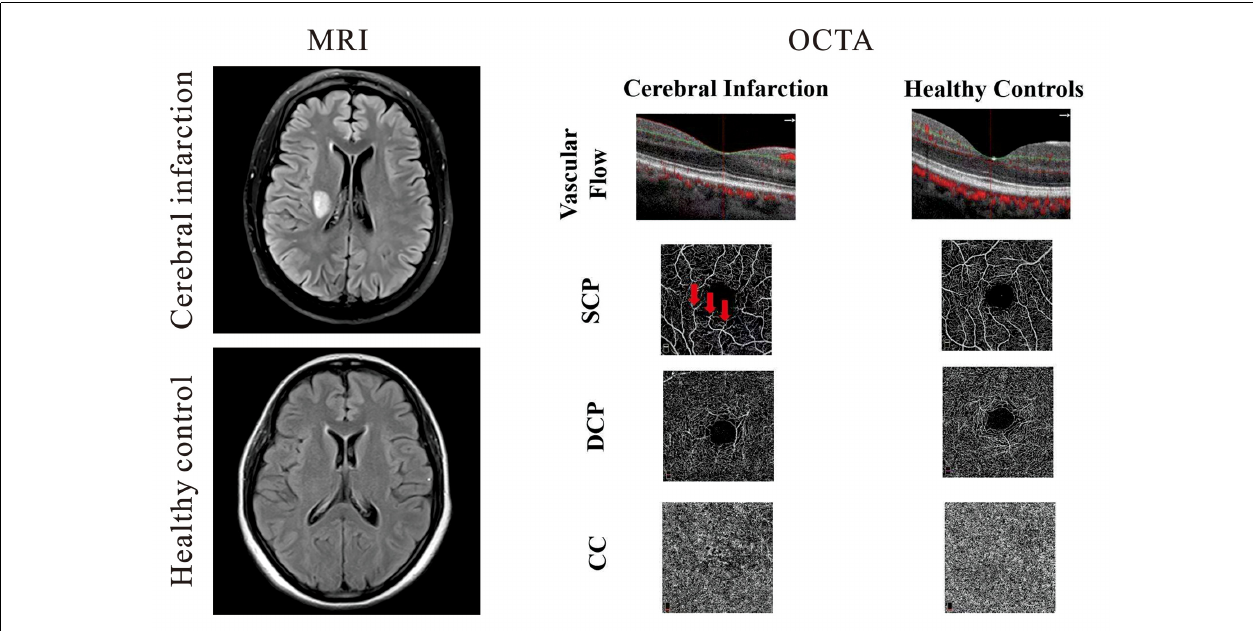
FIGURE 1 | Representative magnetic resonance imaging (MRI) and optical coherence tomography angiography (OCTA) images of cerebral infarction and healthy controls. On the left panel, the upper image shows a T2-weighted MRI of a patient with cerebral infarction beside the right lateral ventricle while the lower right image shows a T2–weighted image of healthy control. Cerebral infarction patients showed reduced vascular flow when compared with healthy controls; macula capillaries were more interrupted in cerebral infarction images when compared with healthy controls. Red arrows represent areas of capillary dropout (middle